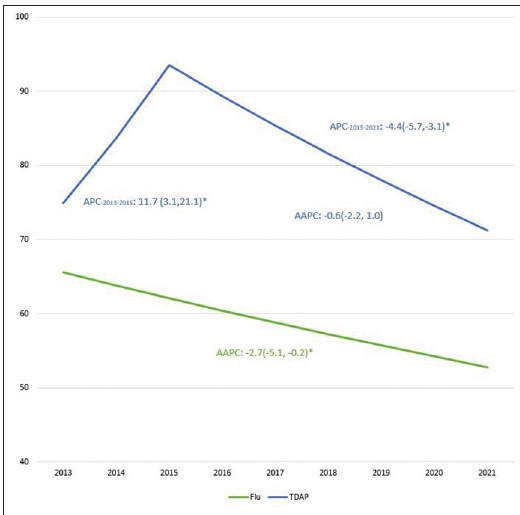
Figure 4 : Temporal trends analysis of flu and TDAP vaccine acceptance over the study period- 2013-2021 APC-Annual percentage change, AAPC-Average annual percent- age